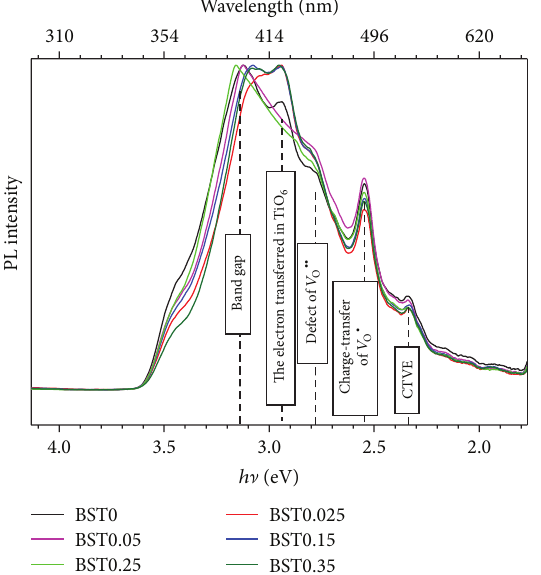
Figure 4: The PL spectra of BST powders with various Na contents.